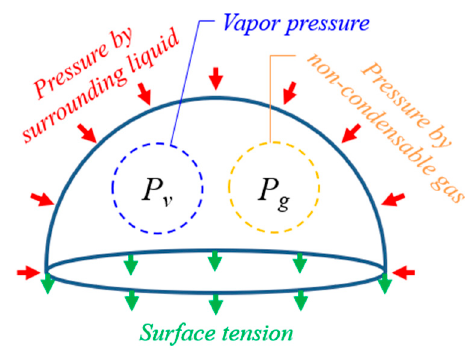
Figure 7. Hydrodynamic forces on the nuclei surface.